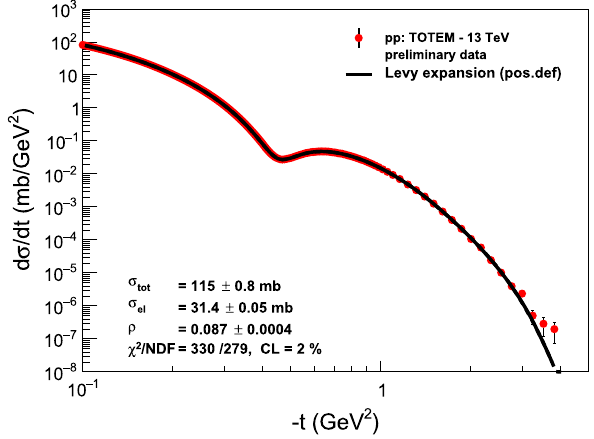
√ s = 13 TeV with their fourth-